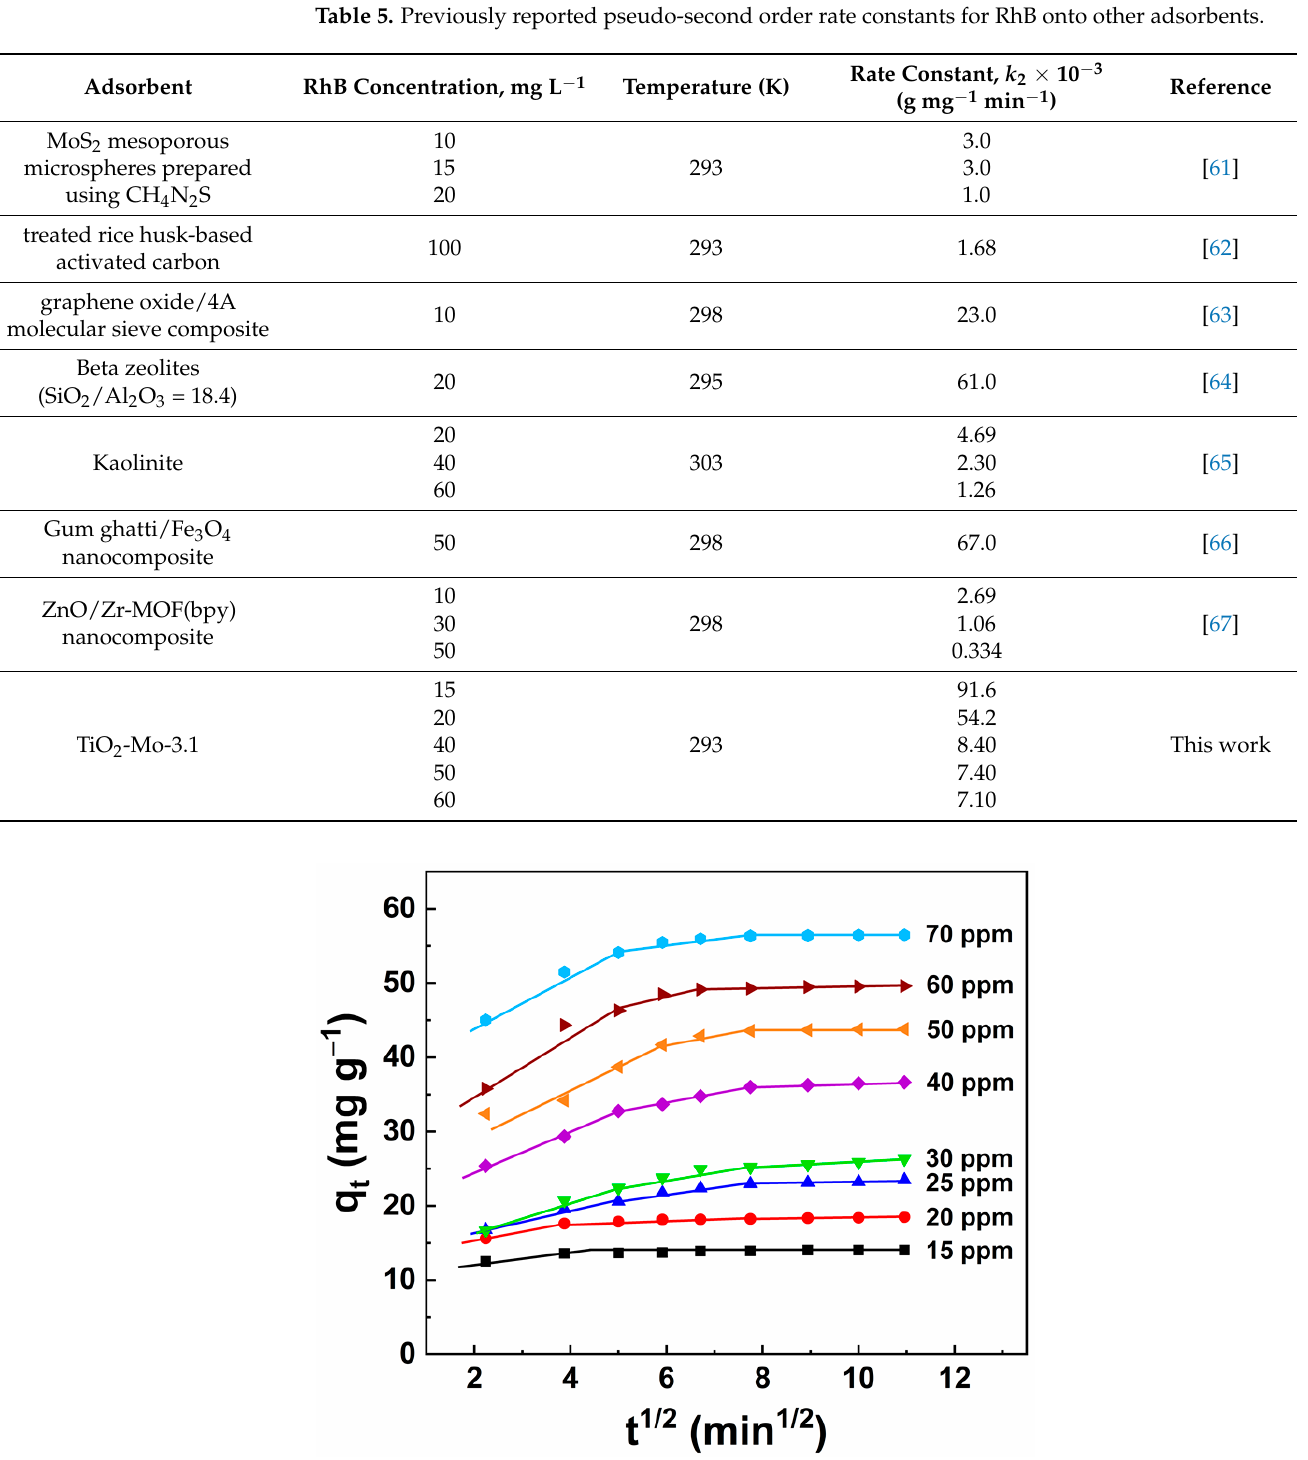
Figure 10. Particle diffusion model of RhB on TiO 2 -Mo-3.1 at different RhB concentrations.